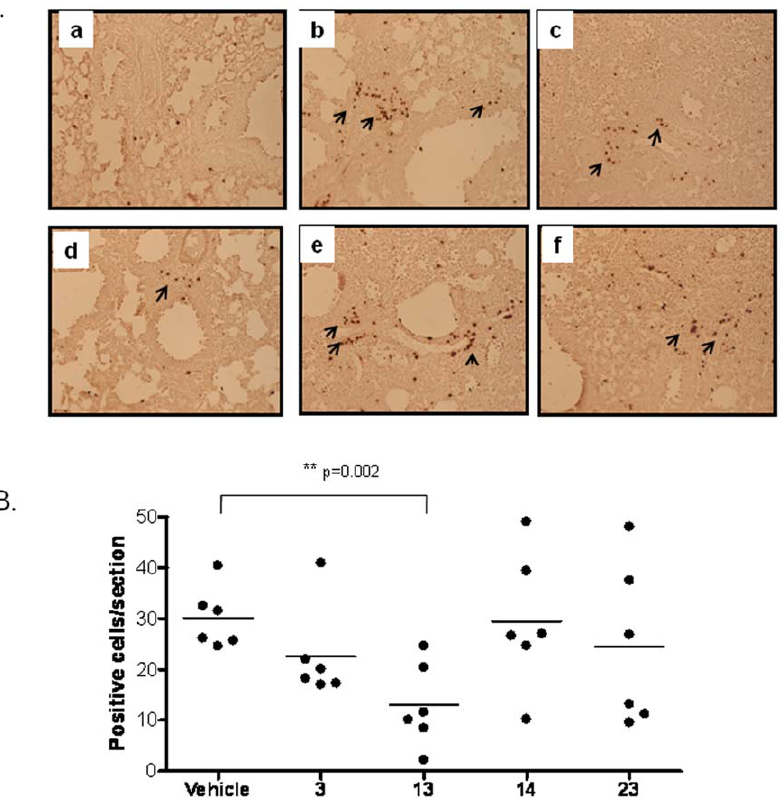
Figure 6. Eosinophil infiltration into the lungs of peptide-immunized transgenic mice upon RSV challenge. Immunohistochemical analysis of lung sections with anti-major basic protein antibody specific for eosinophils followed by the HRP-conjugated anti-rat antibody was performed. (A) Pictures from the section of normal mouse lung (a), or vehicle- (b), peptide 3- (c), 13- (d), 14- (e) and 23- (f) immunized mouse lung section. (B) Quantitative representation of eosinophil count per section of peptide- or vehicle-immunized HLA-transgenic mice at day 4 post RSV challenge. Twenty bright field pictures from each lung mesenchymal region were examined and the number of eosinophils was counted under 200 6 magnification. The mean number of eosinophils in each group, six mice per group, is represented. Similar results from two independent experiments were obtained and one of the results is shown.